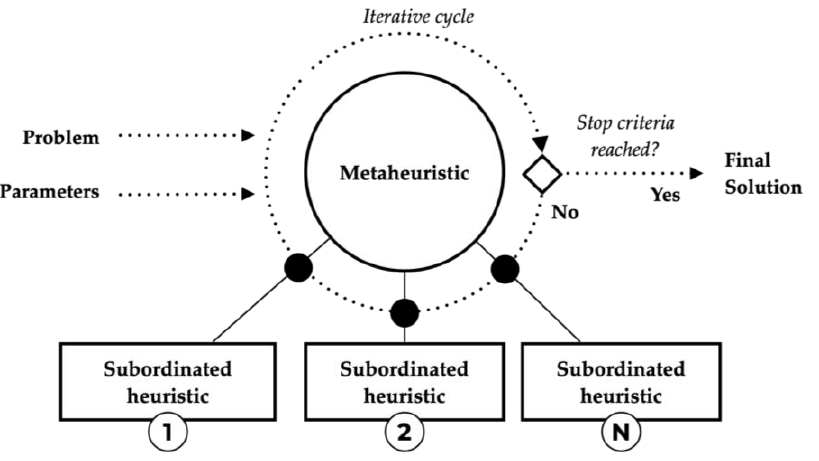
Figure 2. Metaheuristics and subordinated heuristics relationship.